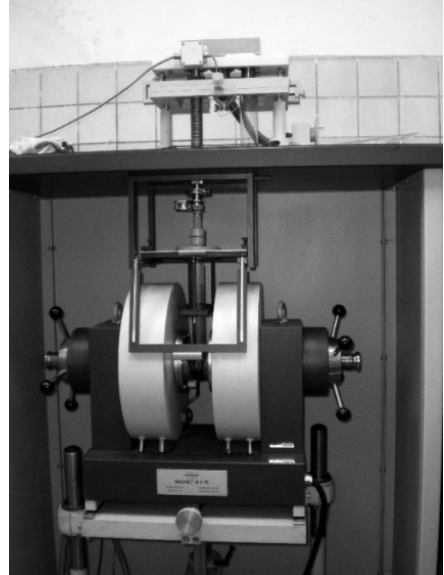
Figure 24. Photo of the experimental setup.